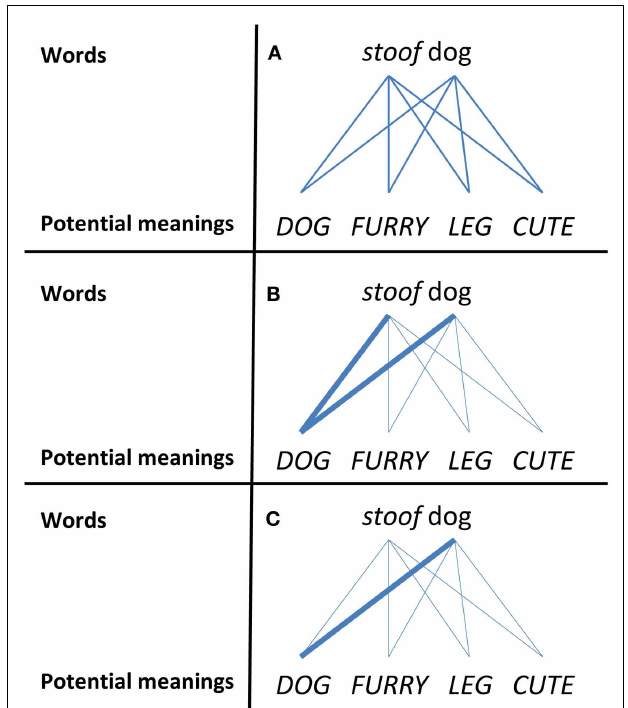
FIGURE 3 | Illustrations of how competition might develop (bold lines) and benefit early adjective learning. (A) The mapping of words to potential meanings is equipotential for a novice learner. (B) The whole object constraint leads to a higher probability of mapping words to the object category over individual properties. (C) Partial exposure to the dog-DOG mapping leads to the inhibition of stoof-DOG and increased activation of